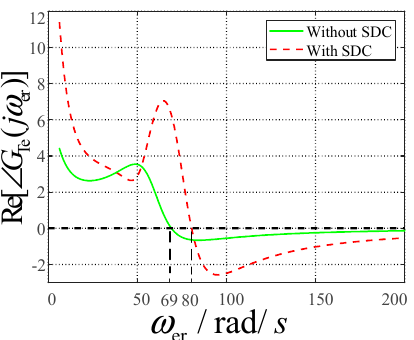
Figure 6. Comparison of subsynchronous damping controller effects.